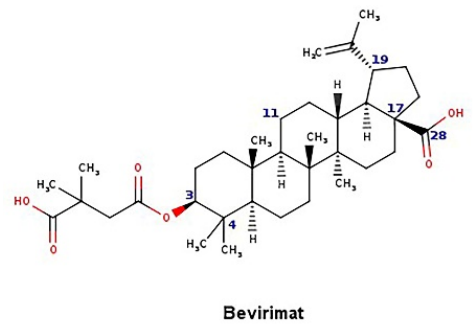
Figure 3. Chemical structure of bevirimat.